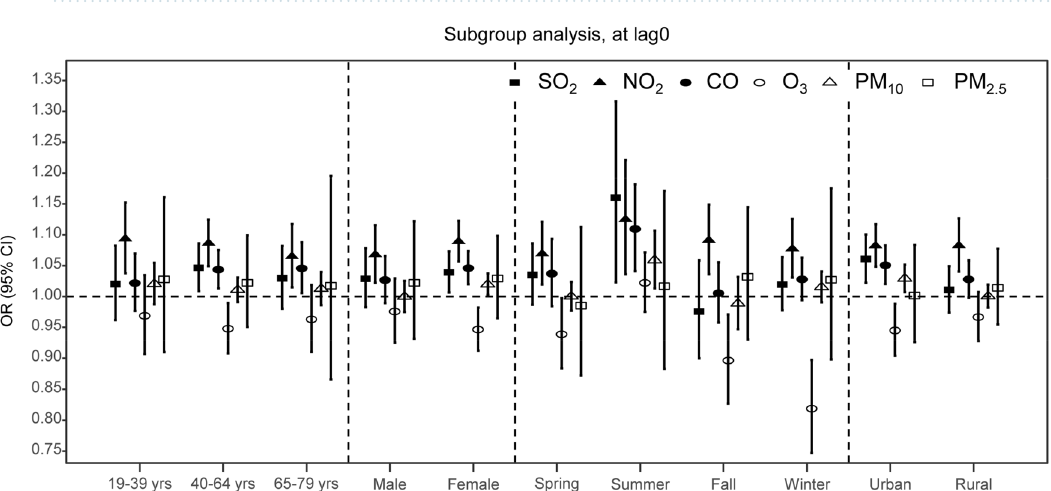
Figure 2. Subgroup analysis of association between Meniere’s disease and air pollution. The pooled effect estimates of odd ratios (ORs) and 95% CIs for Meniere’s disease hospital visits considering interquartile range increase in each air pollutant concentration are presented according to subgroup (potential effect modifiers: age, sex, season, and urbanization of residence). This figure was drawn using R: a Language and Environment for Statistical Computing (version 3.3.3; R Core Team, Vienna, Austria, https:// www.R- proje ct.